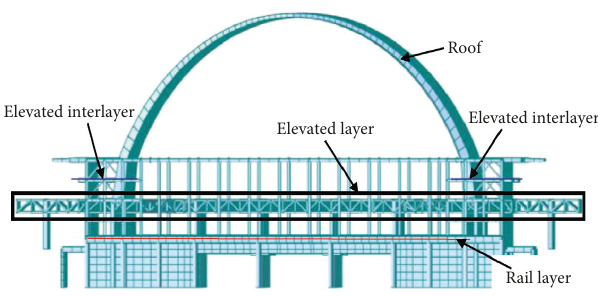
Figure 25: The high-speed railway passenger